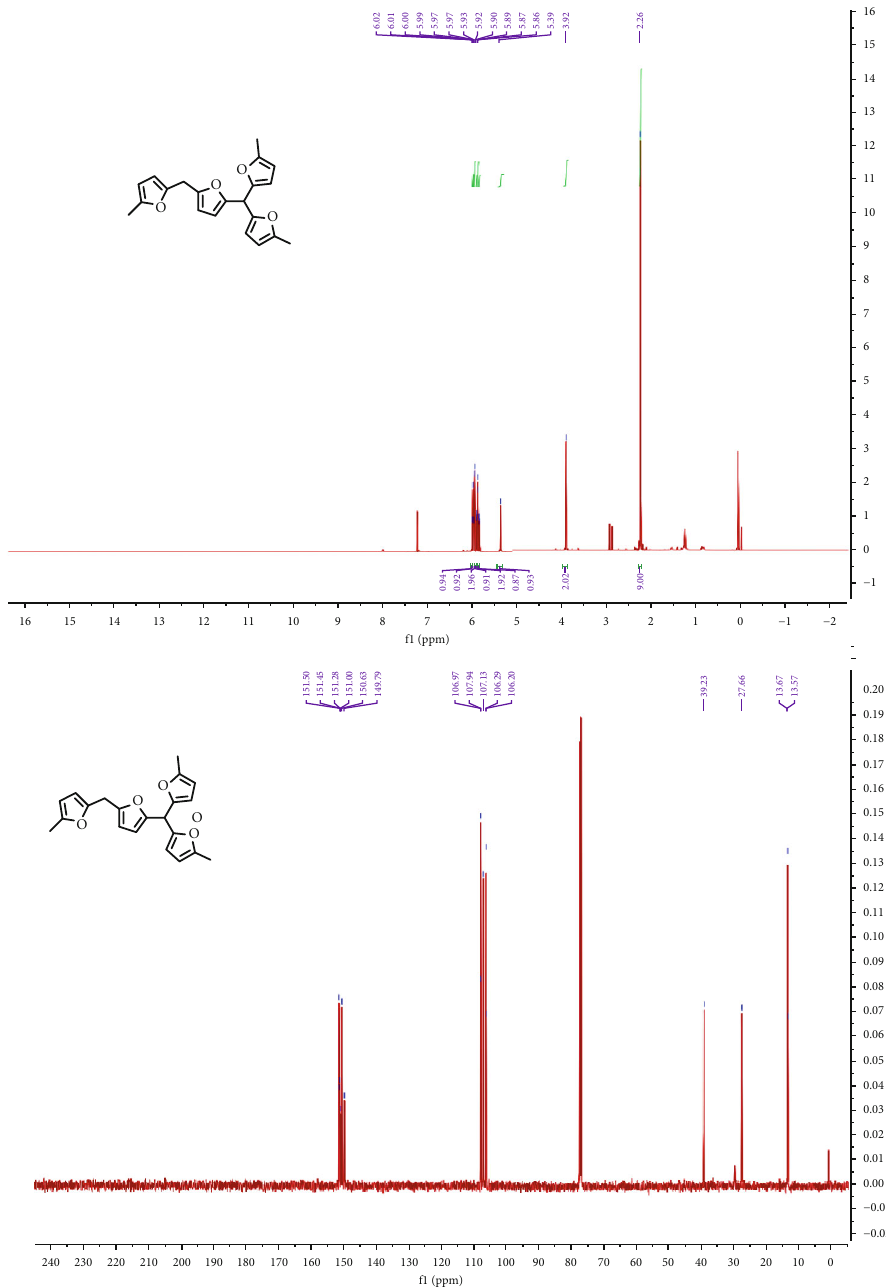
Figure 11: 1 H and 13 C NMR spectra of MMBM. MMBM: 1 H NMR (500MHz, CDCl 5.97 ( d , J = 3 : 1 Hz, 2H), 5.93 ( d , J = 3 : 0 Hz, 1H), 5.90 ( d , J = 3 : 1 Hz, 2H), 5.87 ( d , J = 2 : 9 Hz, 1H), 5.39 (s, 1H), 3.92 (s, 2H), 2.26 (s, 9H). 13 C NMR (126MHz, CDCl ) δ = 151 : 50 , 151.45, 151.28, 151.00, 150.63, 149.79, 107.97, 107.94, 107.13, 106.29, 106.20, 39.23, 27.66, 13.67, 3